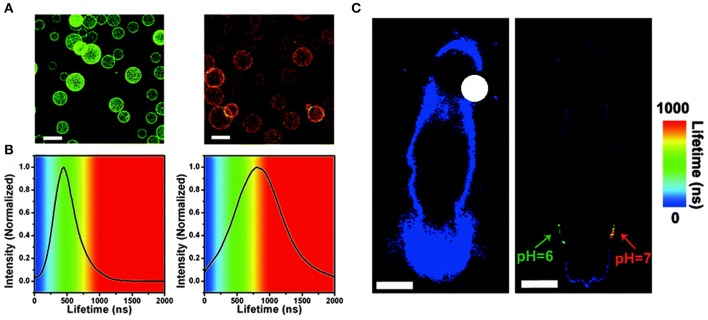
(A) Fluorescence lifetime imaging (FLIM) images of microbeads equipped with QDs-720, dispersed in buffers with different pH values (left: pH = 6.0, right: pH = 7.0, scale bar: 100 mm) and (B) PL lifetime histograms collected from the images. (C)
In vivo FLIM experiments of the background of the nude mouse (left) and the QDs-720 injected into adjacent locations with different pH values (green: pH = 6.0, red: pH = 7.0) on the back of the nude mouse (right), respectively (scale bar: 10 mm) (Chen et al., 2015). Reproduced with permission. Copyright 2015 Royal Society of Chemistry.